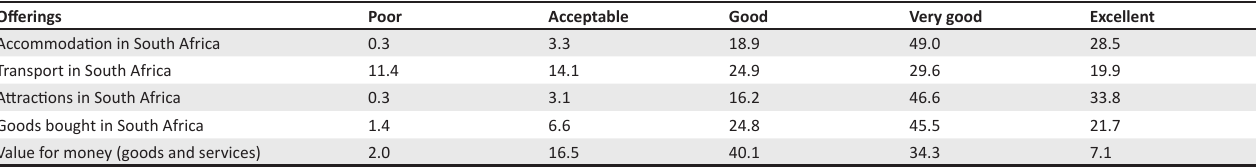
TABLE 2: Respondents’ rating in percentage of goods and services offerings in South Africa ( n = 313). Offerings Poor Acceptable Good Very good Excellent Accommodation in South Africa